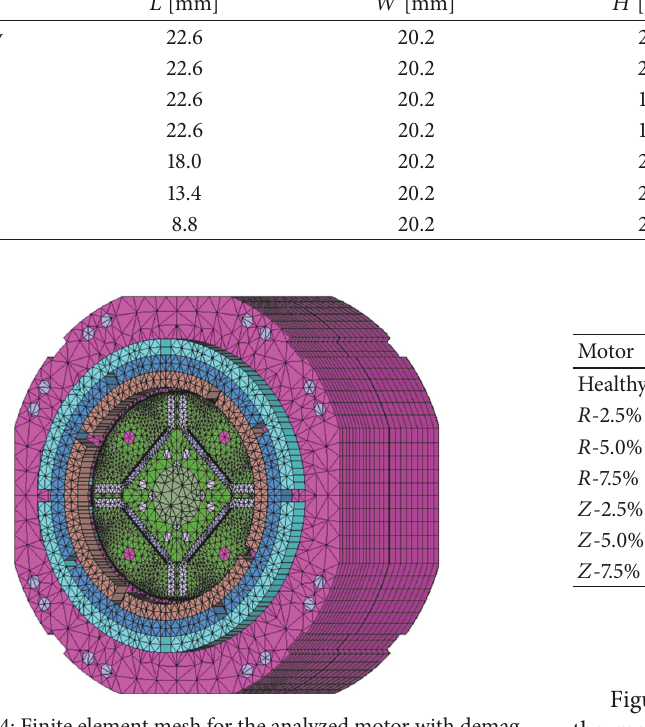
Figure 4: Finite element mesh for the analyzed motor with demag- netized magnet.